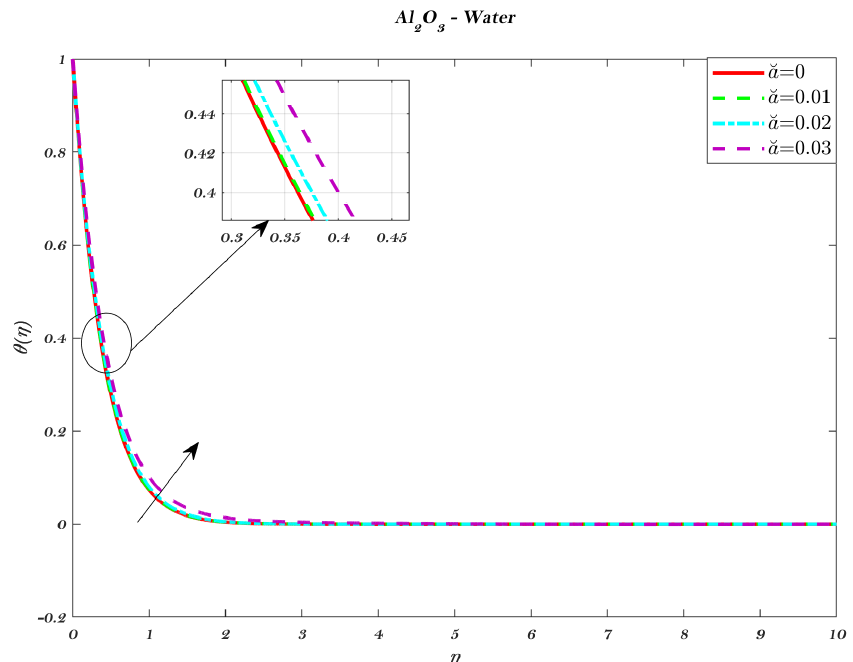
Figure 11. The slip parameters ˘ a against η on the temperature profile with ϕ = 2%, (cid:101) = 0.01 and R =